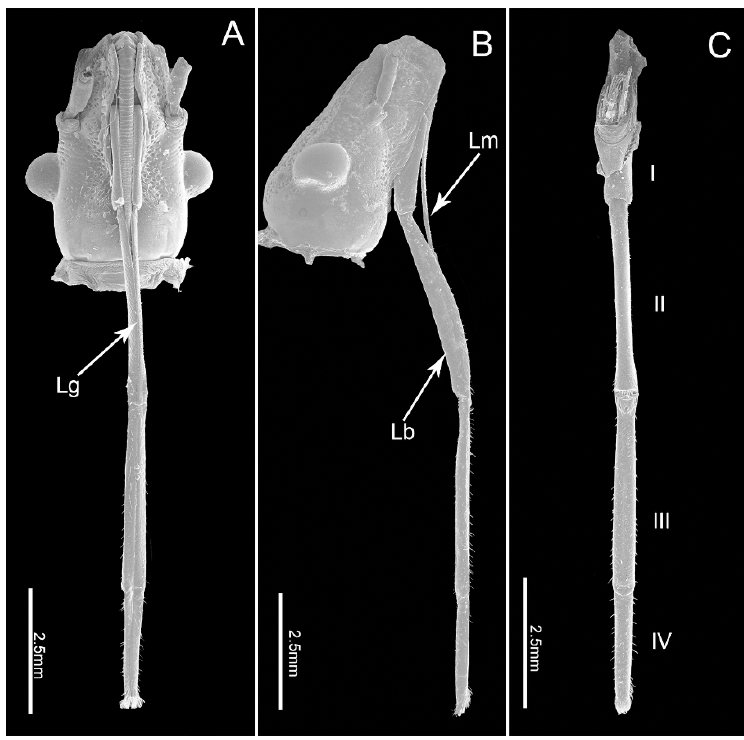
Figure 1. Scanning electron micrographs of the head of E fullo . ( A ) Ventral view; ( B ) Lateral view; ( C ) Dorsal view showing four-segmented labium (I–IV); Lg, labial groove; Lm, labrum; Lb, labium. Table 1. Measurements of labrum and labium (mean ± SE) obtained from scanning electron